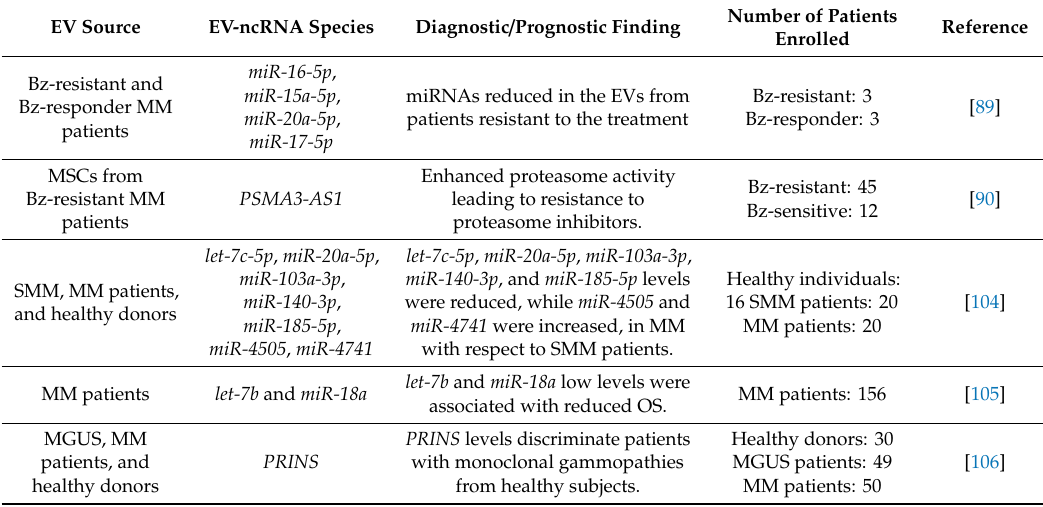
Table 2. Diagnostic and prognostic values of